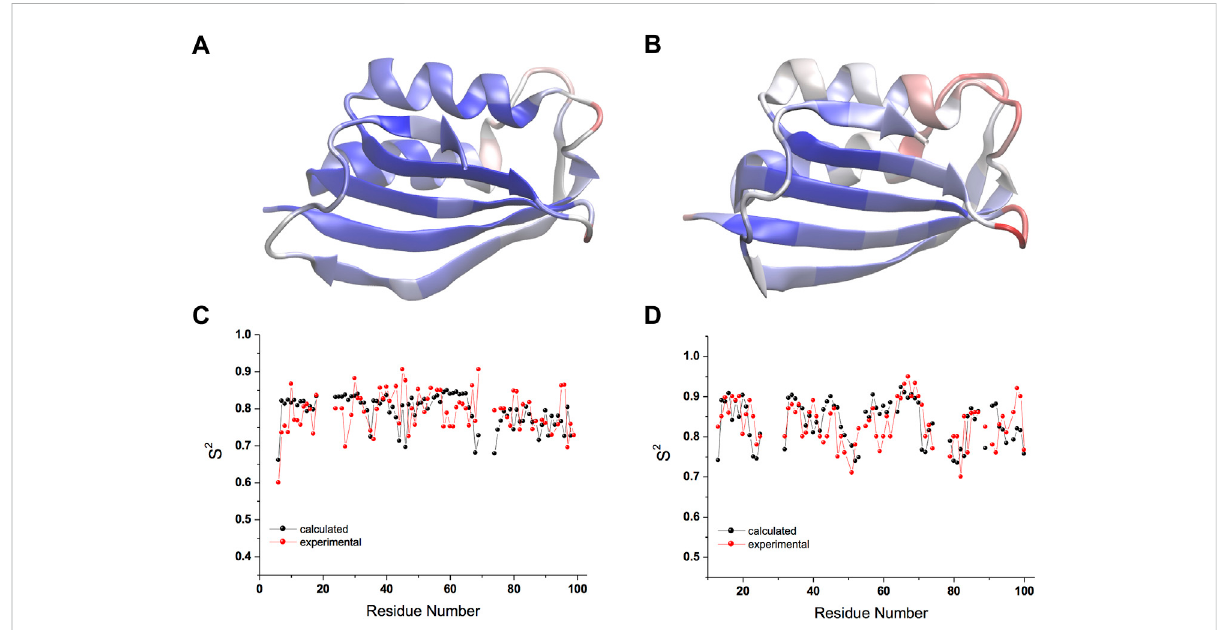
FIGURE 1 Nanosecond structural dynamics of mt AcP at 37 ° C and Sso AcP at 80 ° C. (A,B) root mean square fl uctuations (RMSF) in the CS-restrained MD simulations of mt AcP at 37 ° C (A) and Sso AcP at 80 ° C (B) plotted onto the protein structures. Color code range from low (blue) to high (red) RMSF values. The corresponding RMSF graph is shown in Supplementary Figure S3. (C,D) Order parameters S 2 values of mt AcP at 37 ° C (C) and Sso AcP at 80 ° C (D) calculated from the CS-restrained MD (black) and NMR data (red) from 15 N relaxation measurements Fusco et al.